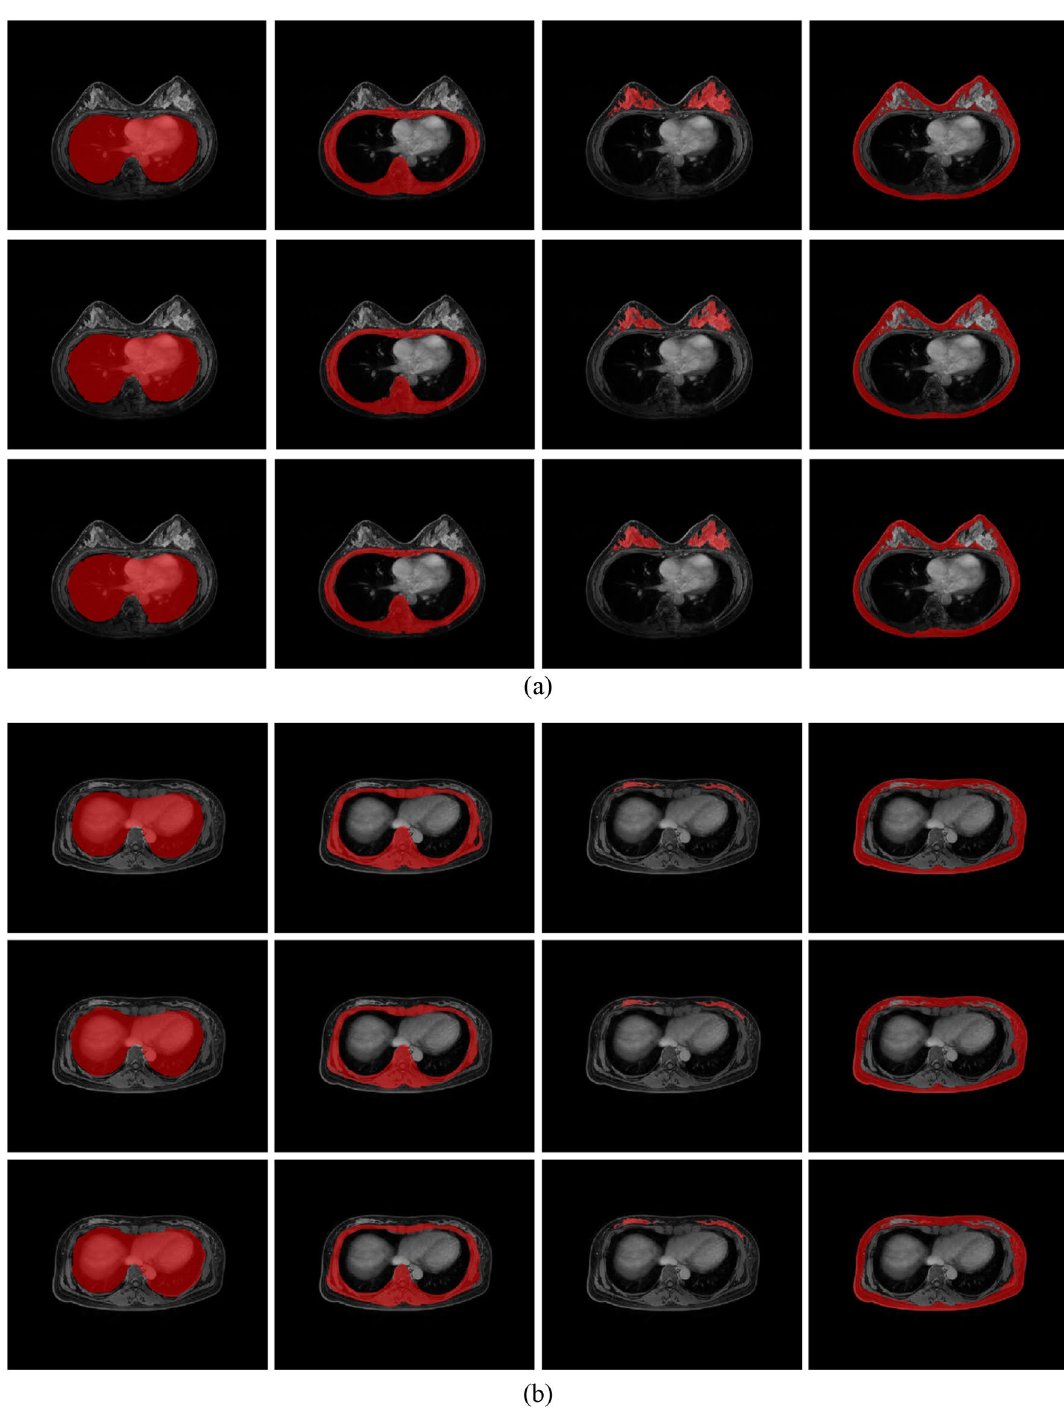
Figure 3. Segmentation results of 2D U-Net for each case (left to right: lungs and heart, muscles and bones, parenchyma with cancer, and skin and fat without parenchyma with cancer). ( a ) results for the prone position; (Upper row: ground truth, second row: prediction results of applying a supine model to prone, bottom row: transfer learning prediction) ( b ) results for the supine position; (Upper row: ground truth, second row: prediction results of applying a prone model to supine, bottom row: transfer learning